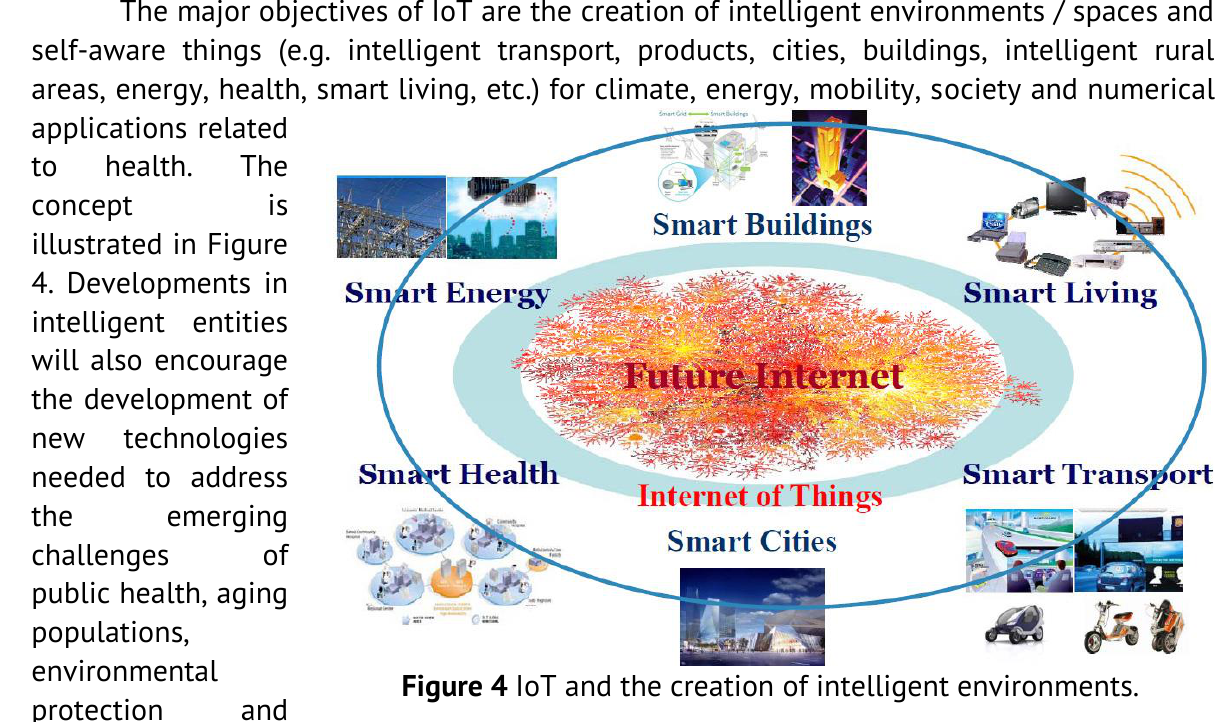
Figure 4 IoT and the creation of intelligent